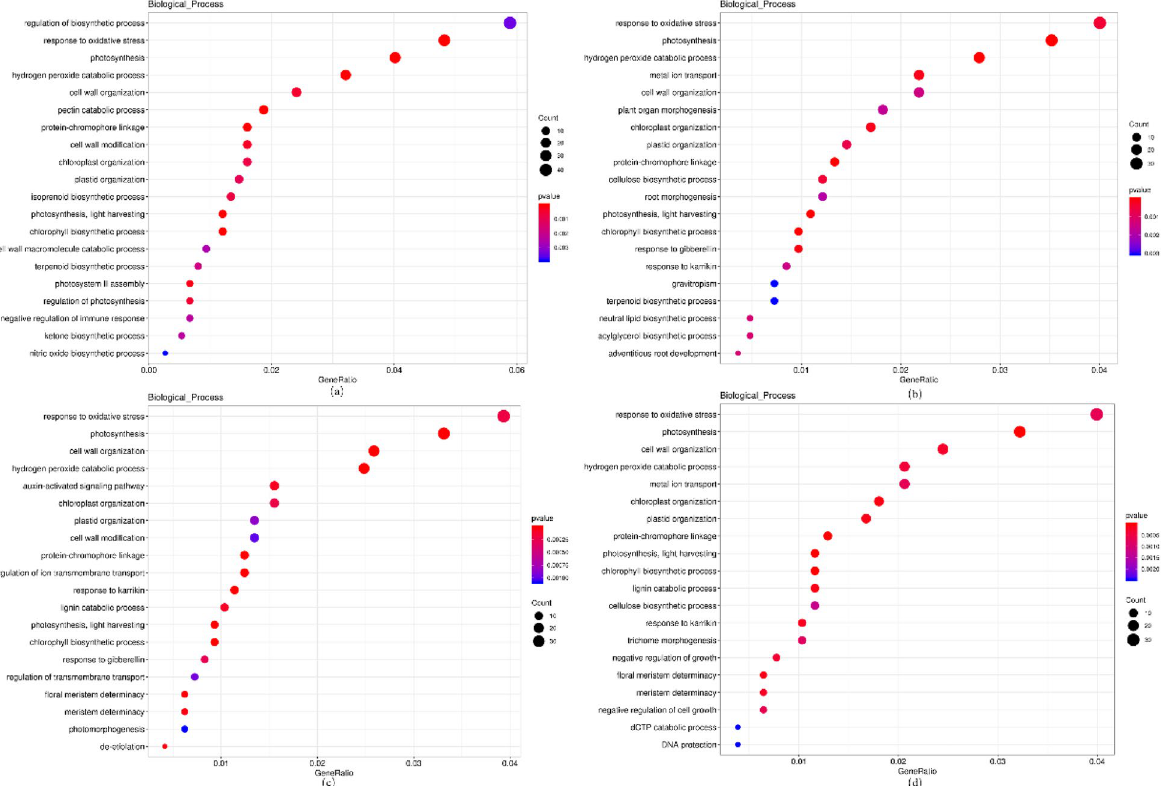
Figure 3. Statistics of the GO annotation classification for the DEGs. ( a ) s0 vs. s1; ( b ) s0 vs. s2; ( c ) s0 vs. s3; ( d ) s0 vs. s4. The abscissa is the GO classification, the right side is the number of genes. From the picture above, we can see the annotation of DEGs and all genes in the secondary GO